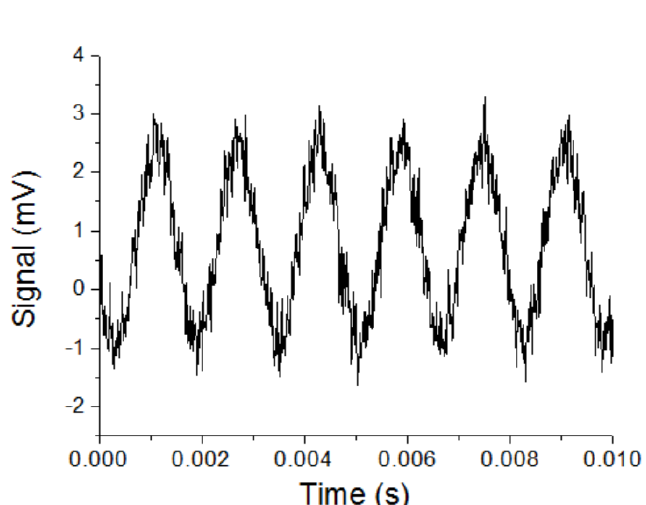
Figure 12. Output signal of the magnetic sensor for the applied magnetic field with a frequency of 630 Hz and the amplitude of 400 pT. A band-pass filter with a bandwidth of 100 Hz was used.